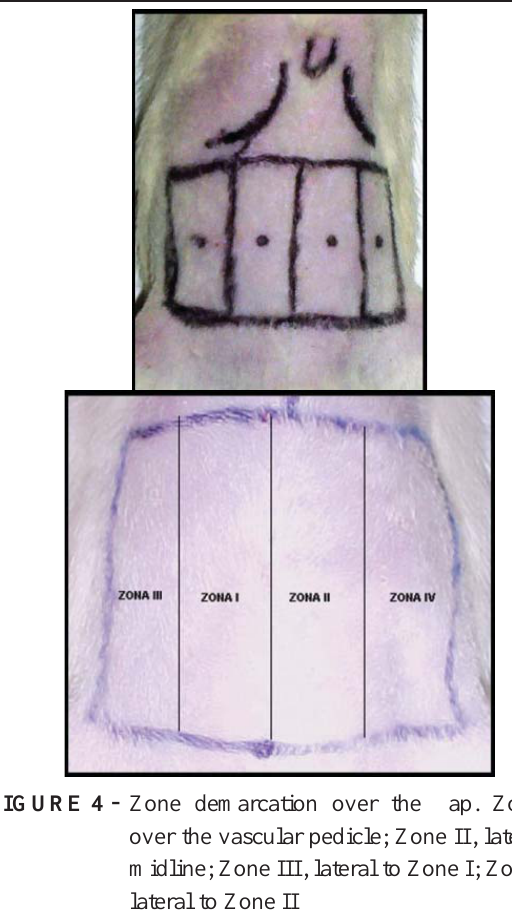
FIGURE 3 - Left: diep fl ap harvested and nourished by deep inferior epigastric perforator vessels. Right: superfi cial inferior right vein dissected and preserved in experimental group